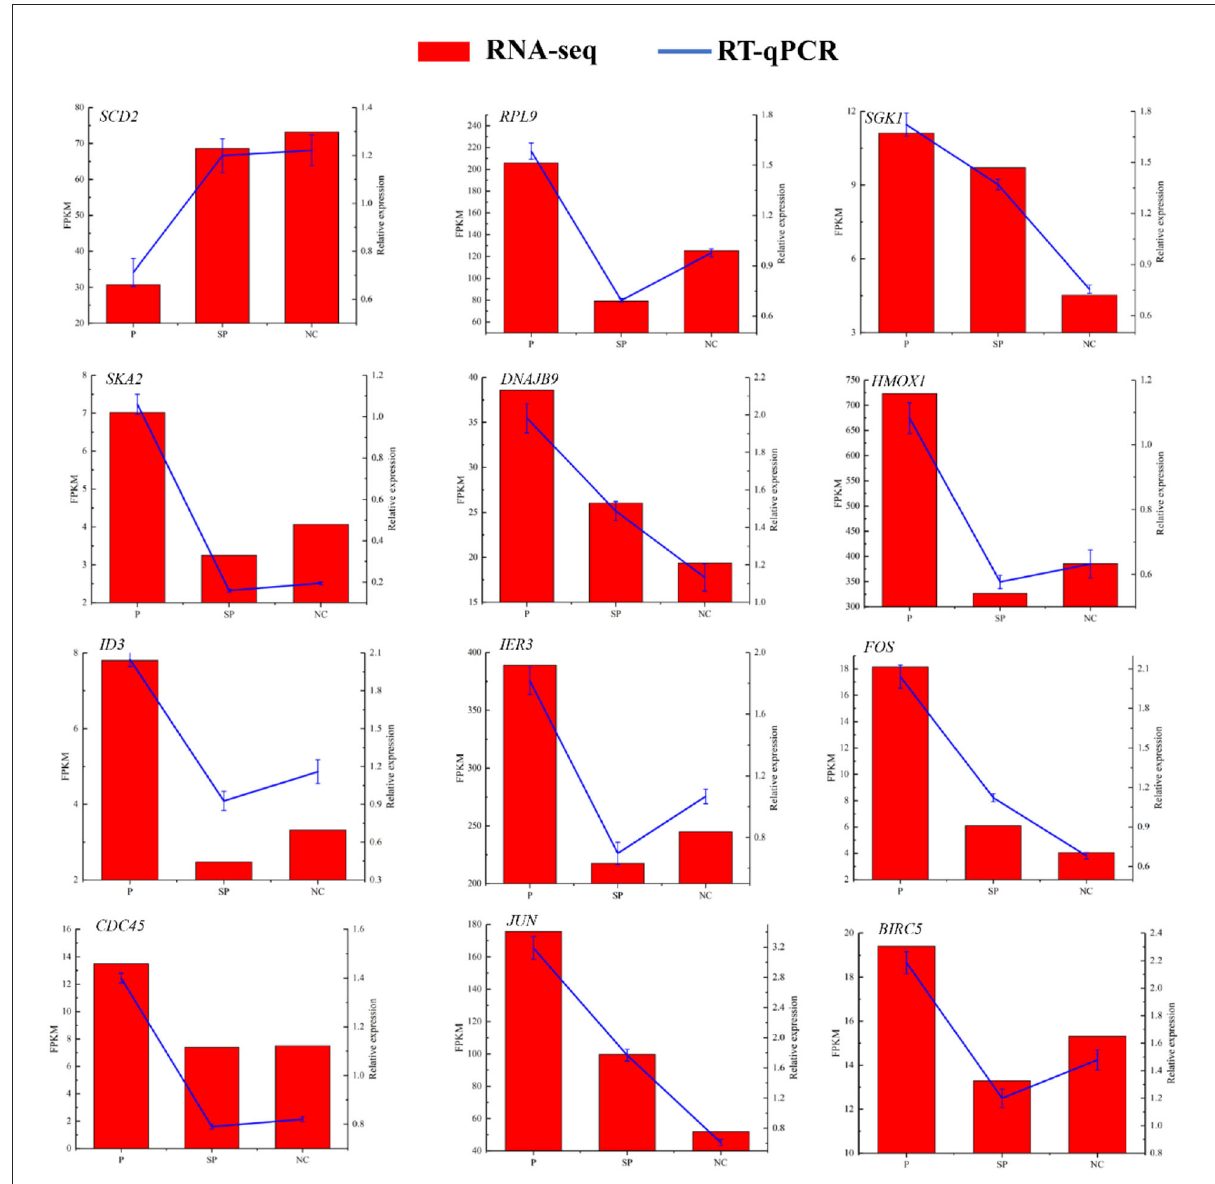
FIGURE3 RT-qPCR to verify the expression pattern of DEGs in RNA-Seq. Histogram represent the relative expression level defense by qRT-PCR (right y-axis). Broken line indicates the change in transcript level according to the FPKM value of RNA-seq (left y-axis).